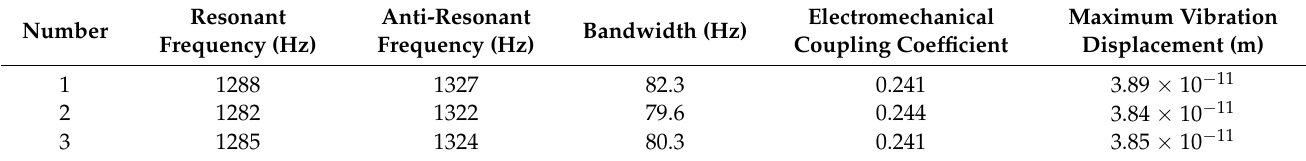
Table 3. Performance test results of piezoelectric ceramics